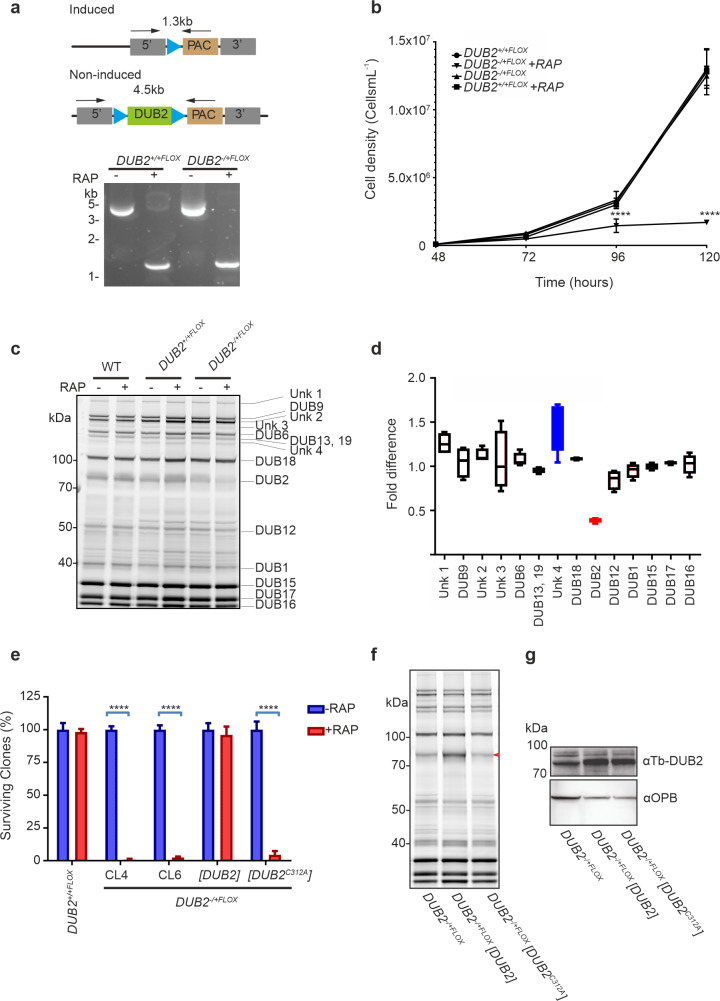
Conditional deletion of DUB2.(A) (Top) Schematic representation of the loxP-flanked DUB2 allele before and after rapamycin-induced recombination by DiCre. Arrows represent the primers used for the PCR to check for the successful excision of DUB2. (Bottom) PCR amplification of DUB2+/+FLOX and DUB2-/+FLOX +/- 100 nM RAP for 48 hours was conducted and the resulting amplicons resolved on 1% agarose gel stain with SYBR safe. (B) DUB2+/+FLOX and DUB2-/+FLOX promastigotes were seeded at a density of 1 × 105 cells mL−1 and grown in the absence or presence (-/+) of 100 nM RAP for 48 h. Cells were diluted to 1 × 105 cells mL−1 and allowed to grow in the presence or absence of 100 nM RAP for 4 d. Cell density was determined by counting at 24 h intervals and mean ± SD of triplicate values were plotted. The data were analysed in Prism software, and an unpaired t-test performed to indicate the significance (n = 5) between different time points, comparing treated with RAP to untreated samples. Error bars show the standard deviation of the mean. ****p < 0.0001. (C) DUBs visualised by in-gel fluorescence analysis after separation by SDS PAGE. Samples were lysed, and 25 μg of lysate was incubated with the probe for 30 min. The positions of the different DUBs are indicated. (D) Fold difference of the DUB activity comparing DUB2 induced/DUB2 non-induced of the DUB2-/+FLOX, data from (C). Band intensities were quantified by densitometry using GelAnalyzer 19.1 software. Each band is represented as a percentage of the total activity. The percentages for each band for the induced sample were divided by the non-induced to determine the fold difference. The data were then analysed in Prism software. Each column represents the mean of data from three independent experiments. Error bars show the standard deviation of the mean. Blue represents an increase of more than 1.3-fold whereas red represents a difference of less than 0.7-fold. (E) Percentage of surviving clones of DUB2+/+FLOX, DUB2-/+FLOX clone 4, DUB2-/+FLOX clone 6, DUB2-/+FLOX [DUB2] and DUB2-/+FLOX [DUB2C312A] promastigotes after RAP induction. The cell lines were incubated with or without RAP for 48 hours. Next, cells were counted and cloned into 96 well plates. After 4 weeks, plates were checked for surviving parasites. The data were then collected and analysed in Prism software. 100% represents the highest number of surviving parasites that were collected from an individual experiment in the absence of RAP. Each column represents the mean of data from three independent experiments. Error bars show the standard deviation of the mean. ****p < 0.0001. (F) DUBs were visualised by in-gel fluorescence analysis after separation by SDS-PAGE. Samples were lysed and 25 μg of lysate was incubated with the probe for 30 min. Lysate was collected from DUB2-/+FLOX, DUB2-/+FLOX [DUB2] and DUB2-/+FLOX [DUB2C312A] promastigotes grown in the presence of 10 μg μL−1 of G418. (G) Western blotting analysis with anti-TbDUB2 (1:1,000) and anti-LmOPB (1:20,000) (loading control) antibodies on protein extracted from DUB2-/+FLOX, DUB2-/+FLOX [DUB2] and DUB2-/+FLOX [DUB2C312A] promastigotes grown in the presence of 10 μg μL−1 of G418.